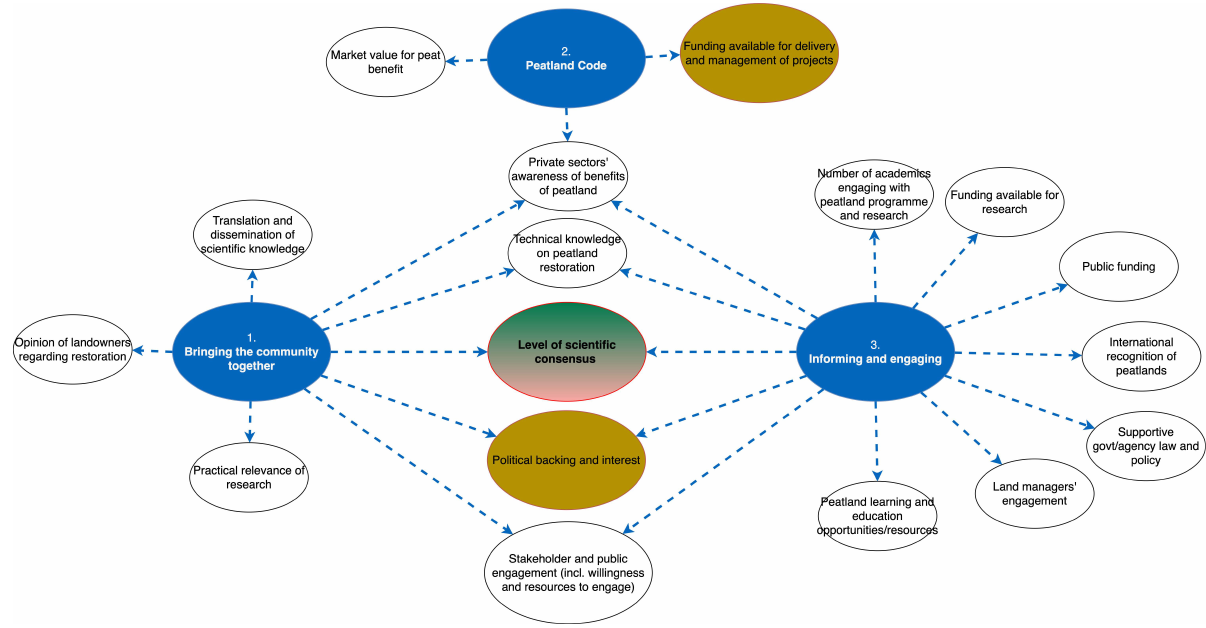
Figure 5. Submap one step downstream of Peatland Programme